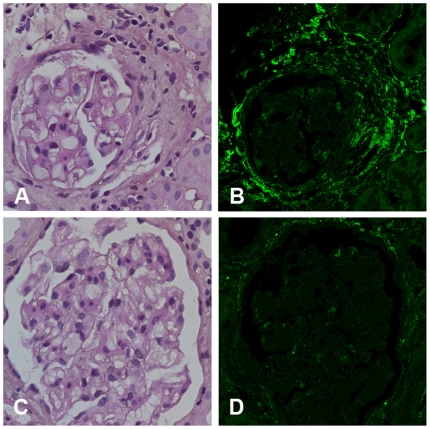
PAS staining of sclerotic glomeruli from a representative IgAN patient (A), and the consecutive section stained for decorin (B) shows overlap of the sclerotic area and decorin staining.PAS staining of glomeruli without sclerosis (C) and consecutive section showing no staining for decorin (D) in the same patient. Decorin is abundantly expressed in sclerotic glomeruli both in controls and patients with IgAN, but not in non-sclerotic glomeruli. Magnification ×63.